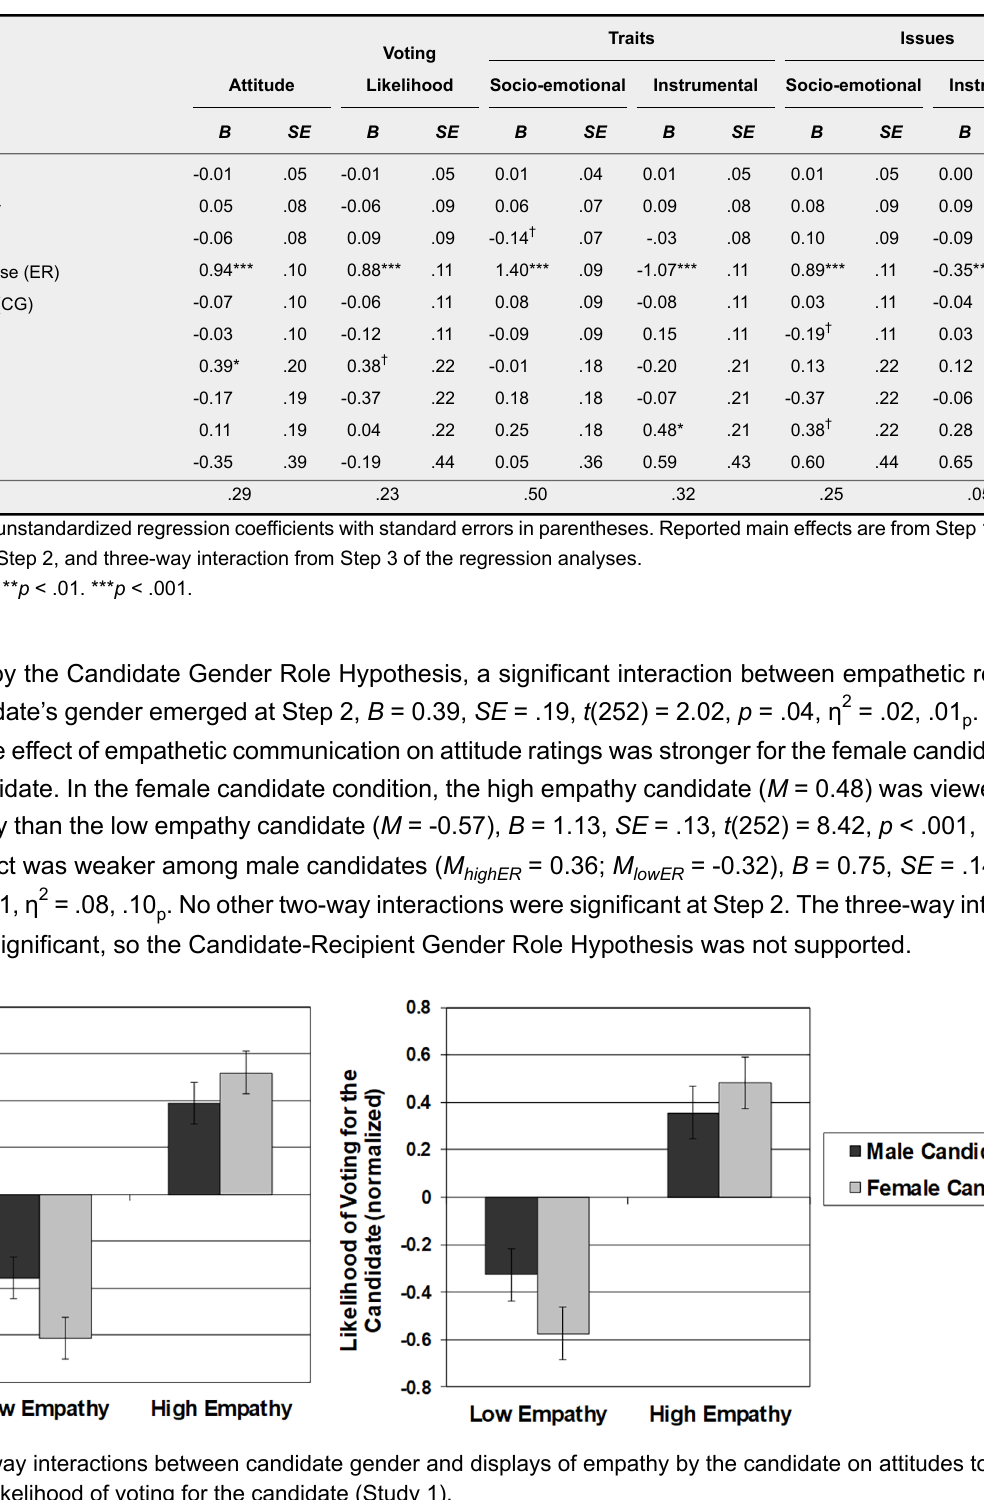
Candidate Ratings as a Function of Empathetic Response, Candidate Gender, and Town-hall Voter Gender, Study 1